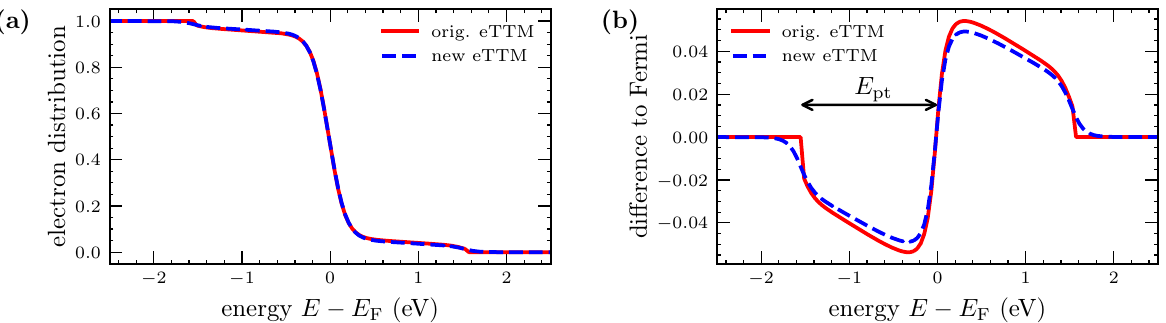
Figure 4. Electron distributions at the maximum of the laser pulse. The original eTTM by Tsibidis [43] is compared to the new and modified version presented in this paper. Figure ( a ) shows the electron distribution, Figure ( b ) the difference to the equilibrium background. The step is visible and has a width that equals the photon energy E pt = 1.55 eV, as was explained in the theory part of the model (see Section 2). While the differences in total are small (see ( a )), the new model prevents the unphysical kink at the edges of the laser-disturbed energy range by distributing the energy of the laser over a wider energy range (see ( b